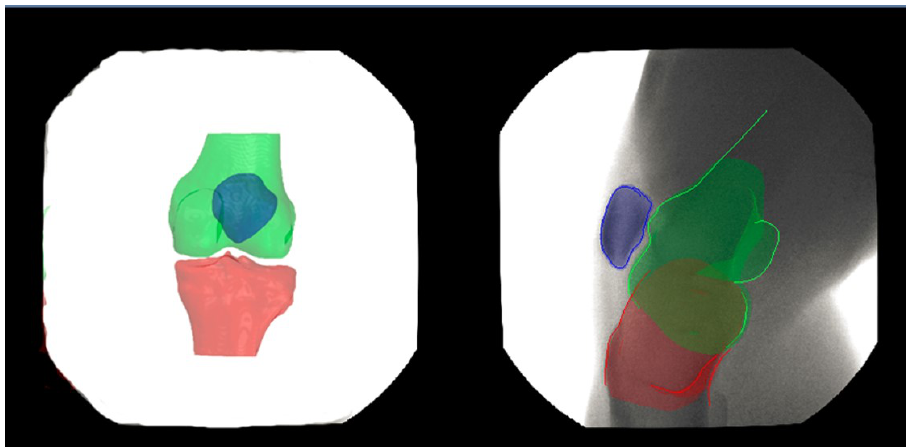
Figure 5. Example of a 3D knee template re-projected into one fluoroscopic image. The red color correspond to the tibia, the green color to the femur, and the blue color to the patella.